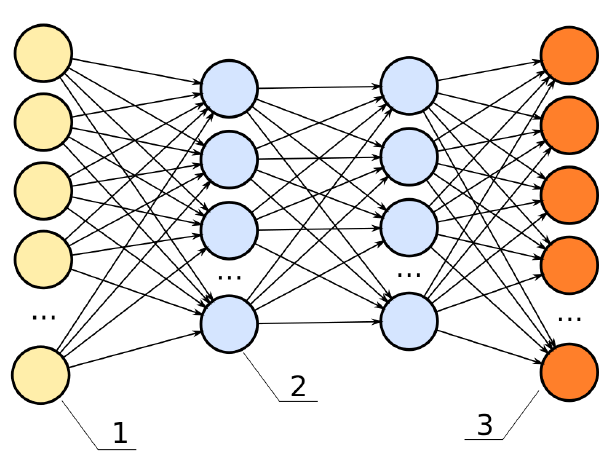
Figure 3. The structure of DNN model. Image distributed under a CC BY-SA 4.0 license. Number one represents input layer followed by two which are the hidden layers and finally three which is the output